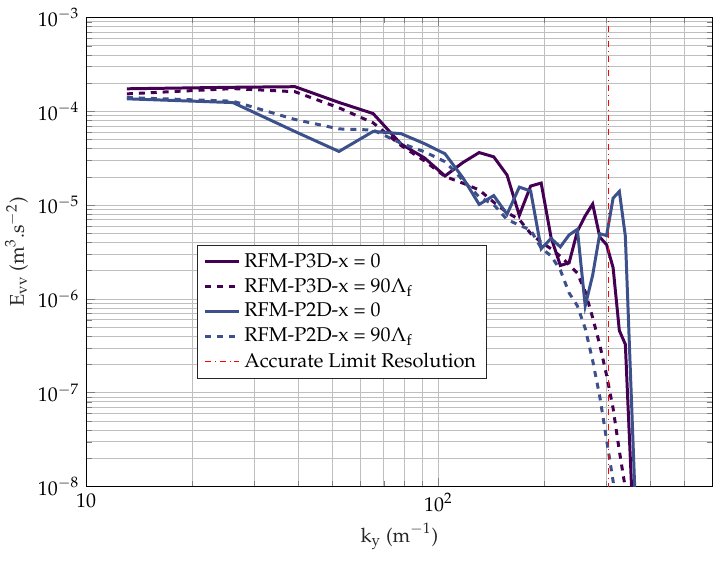
Figure 11. One-dimensional spectra for the Single Grid configuration for RFM-P2D and RFM-P3D